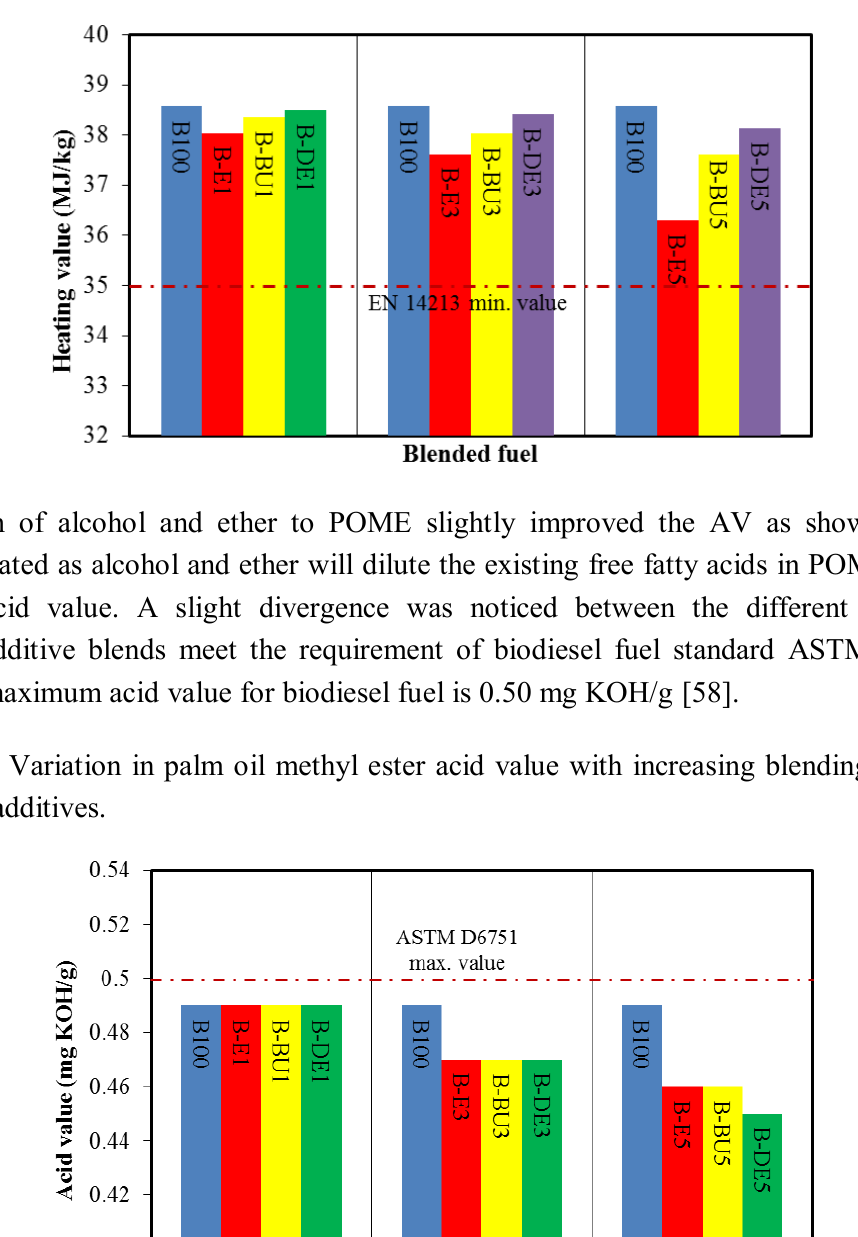
Figure 5. Variation in palm oil methyl ester heating value with increasing blending ratio for different chemical additives.